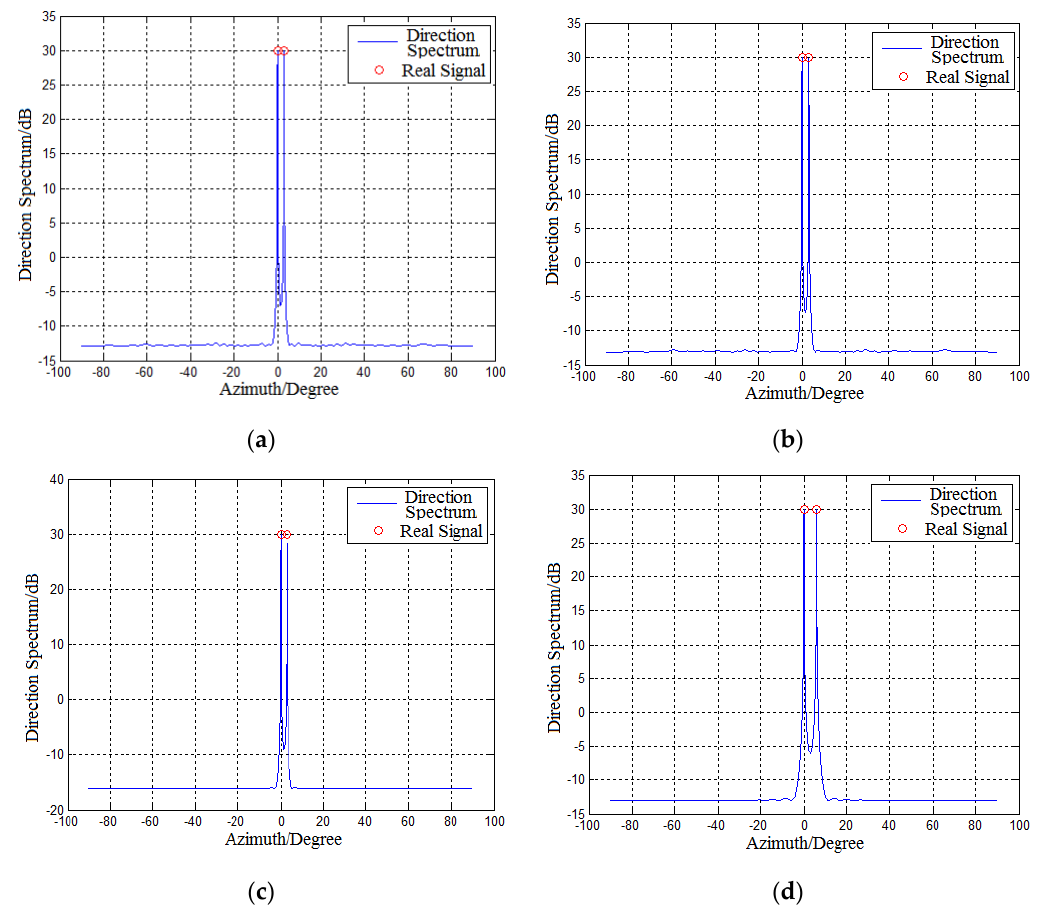
Figure 10. Azimuth resolution of four different arrays. ( a ) Sparse array after ADS implementation